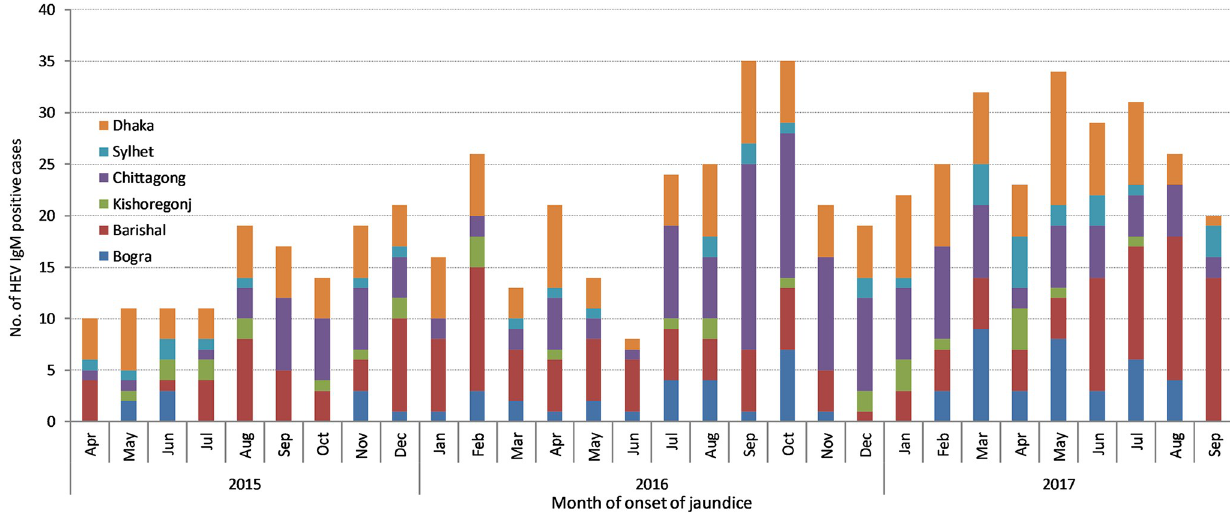
Fig 3. Number of anti-HEV IgM positive cases by the month of onset of jaundice among patients with acute jaundice admitted in six tertiary hospitals in Bangladesh, April 2015–September 2017. Note: Since surveillance was established in all hospitals by March, 2015, the seasonality curve covered the period from April 2015 to September 2017.